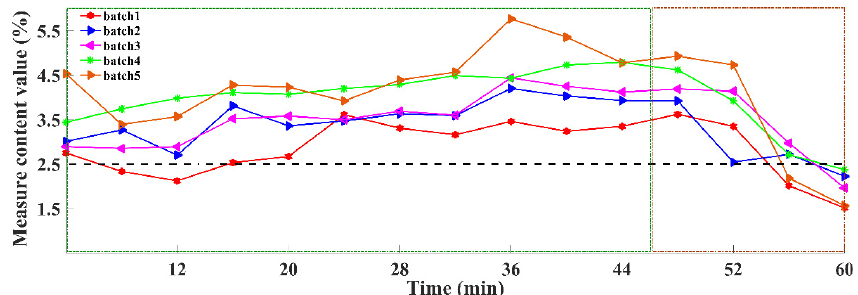
Fig. 4. The trend of the reference data in the granulation process corresponds to the green part of the ¯gure, and the trend of the reference data in the drying process corresponds to the red part of the